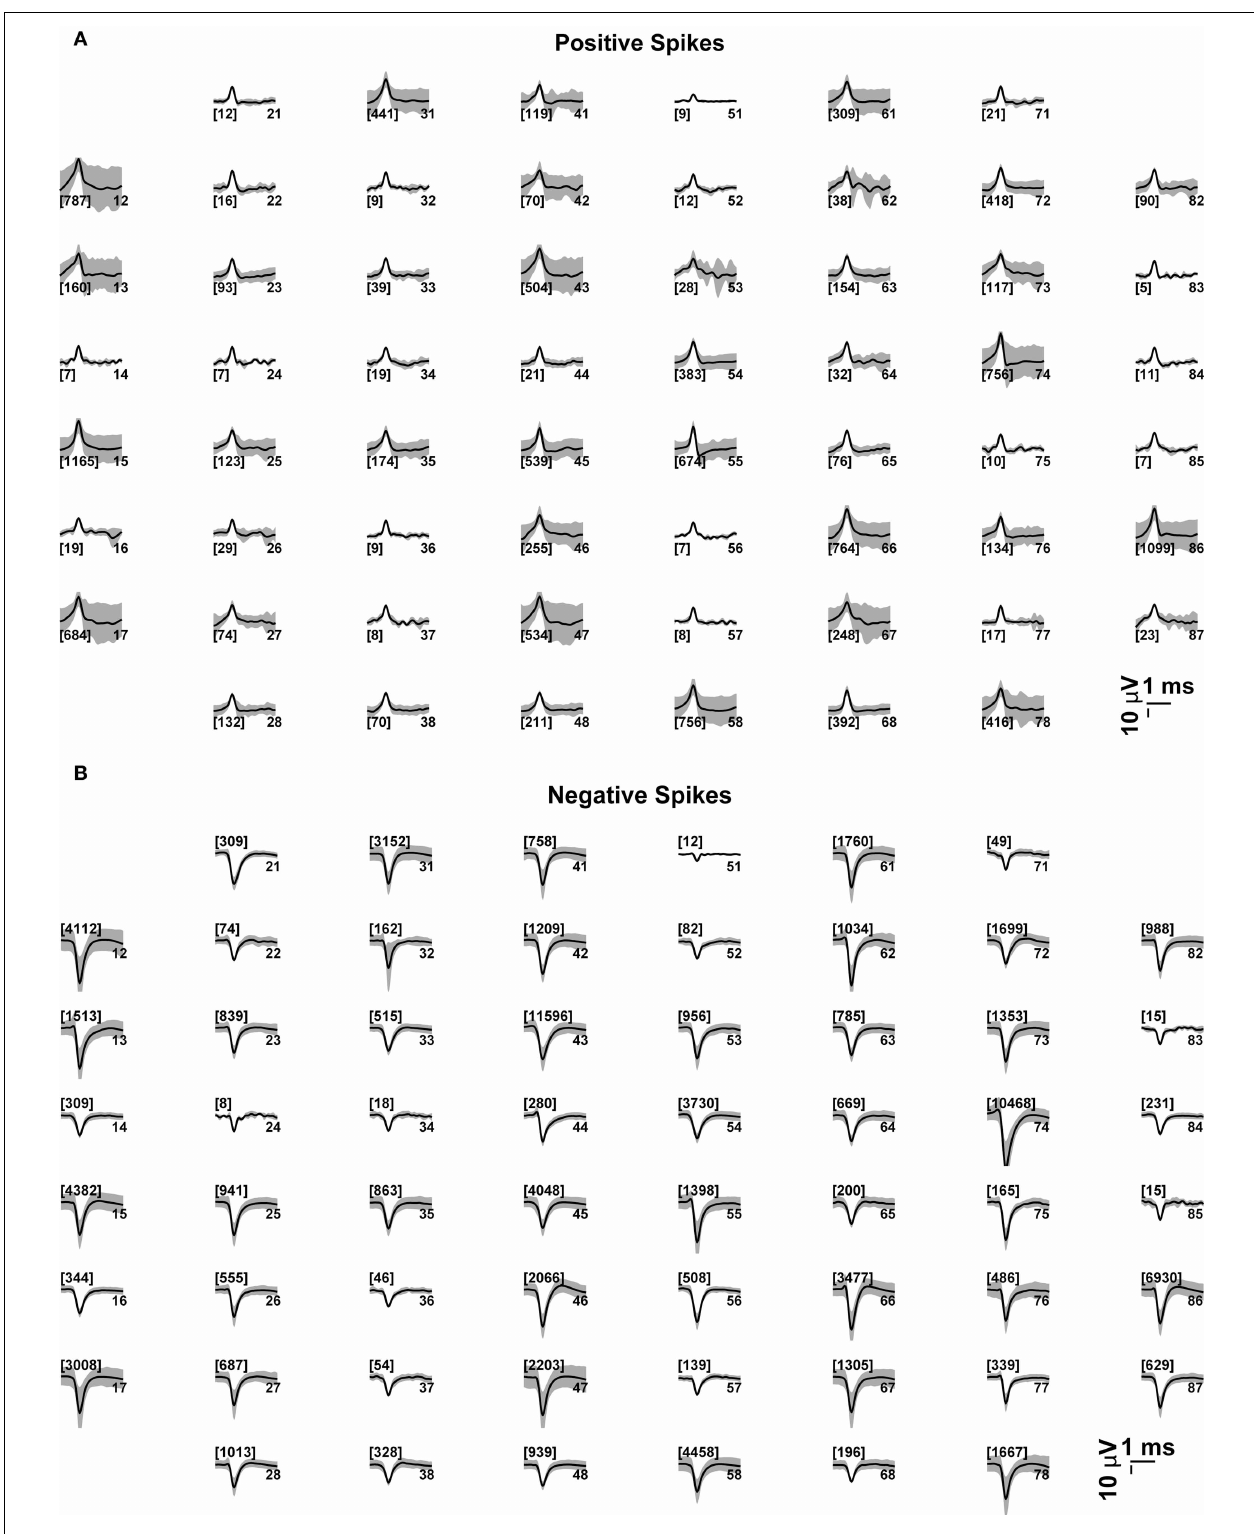
FIGURE 6 | Average voltage waveforms, corresponding to (positive or negative) peak-detection events at each microelectrode. Each subplot represents graphically the 8 × 8 layout of the MEAs employed in this study (see the Methods). The average voltage trajectories (thick black lines) of the positive (A) or negative